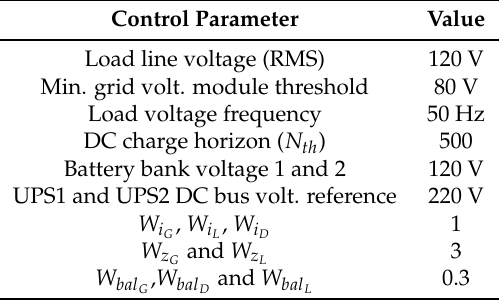
Table 4. Control